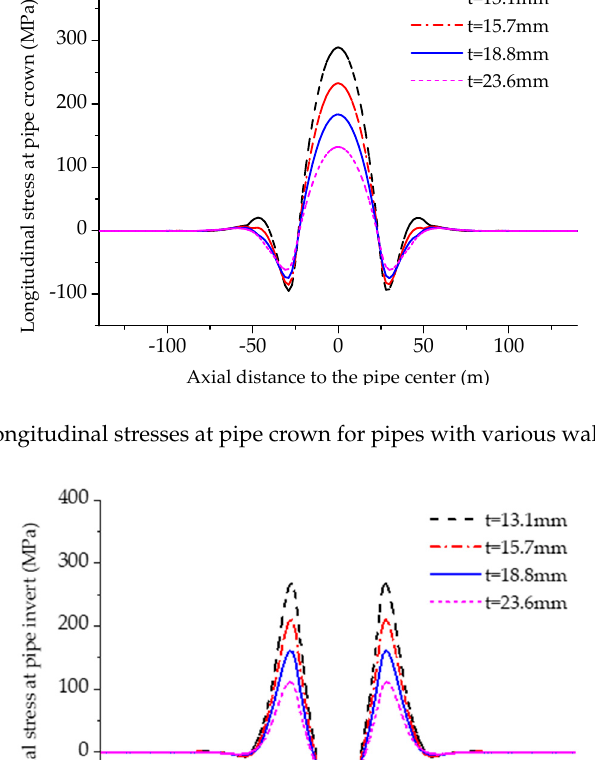
Figure 14. Vertical deformations for pipes with various wall thicknesses.